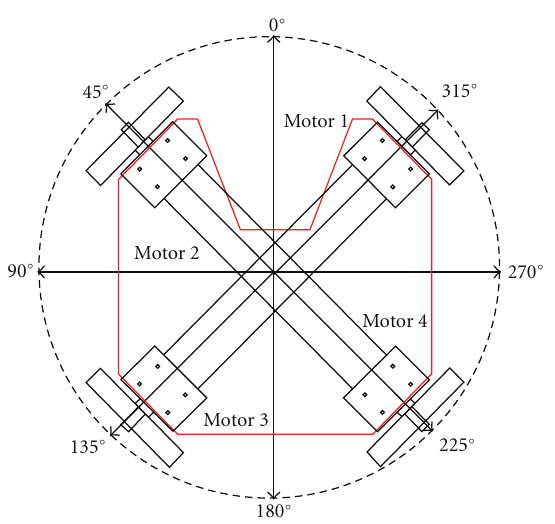
Figure 11: The PCB layout.